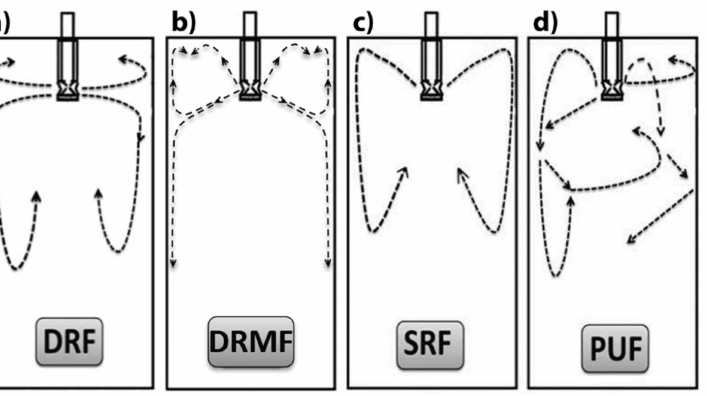
Figure 1. The steel flow pattern in a slab mold. ( a ) Double roll flow. ( b ) Double roll mixing flow. ( c ) Single roll flow. ( d ) Permanent unstable flow.